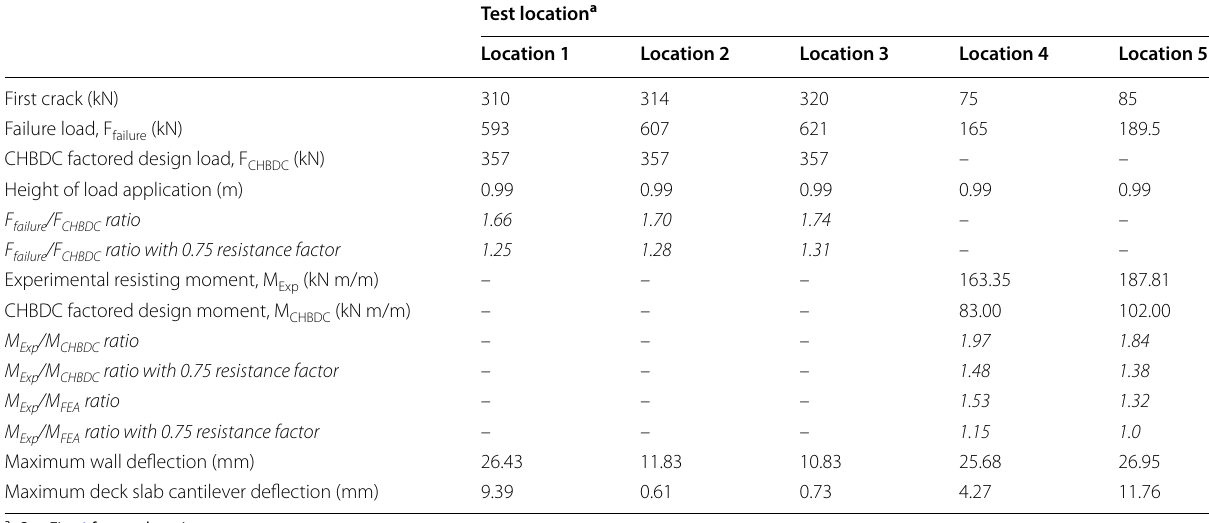
Table 1 Summary of experimental results.